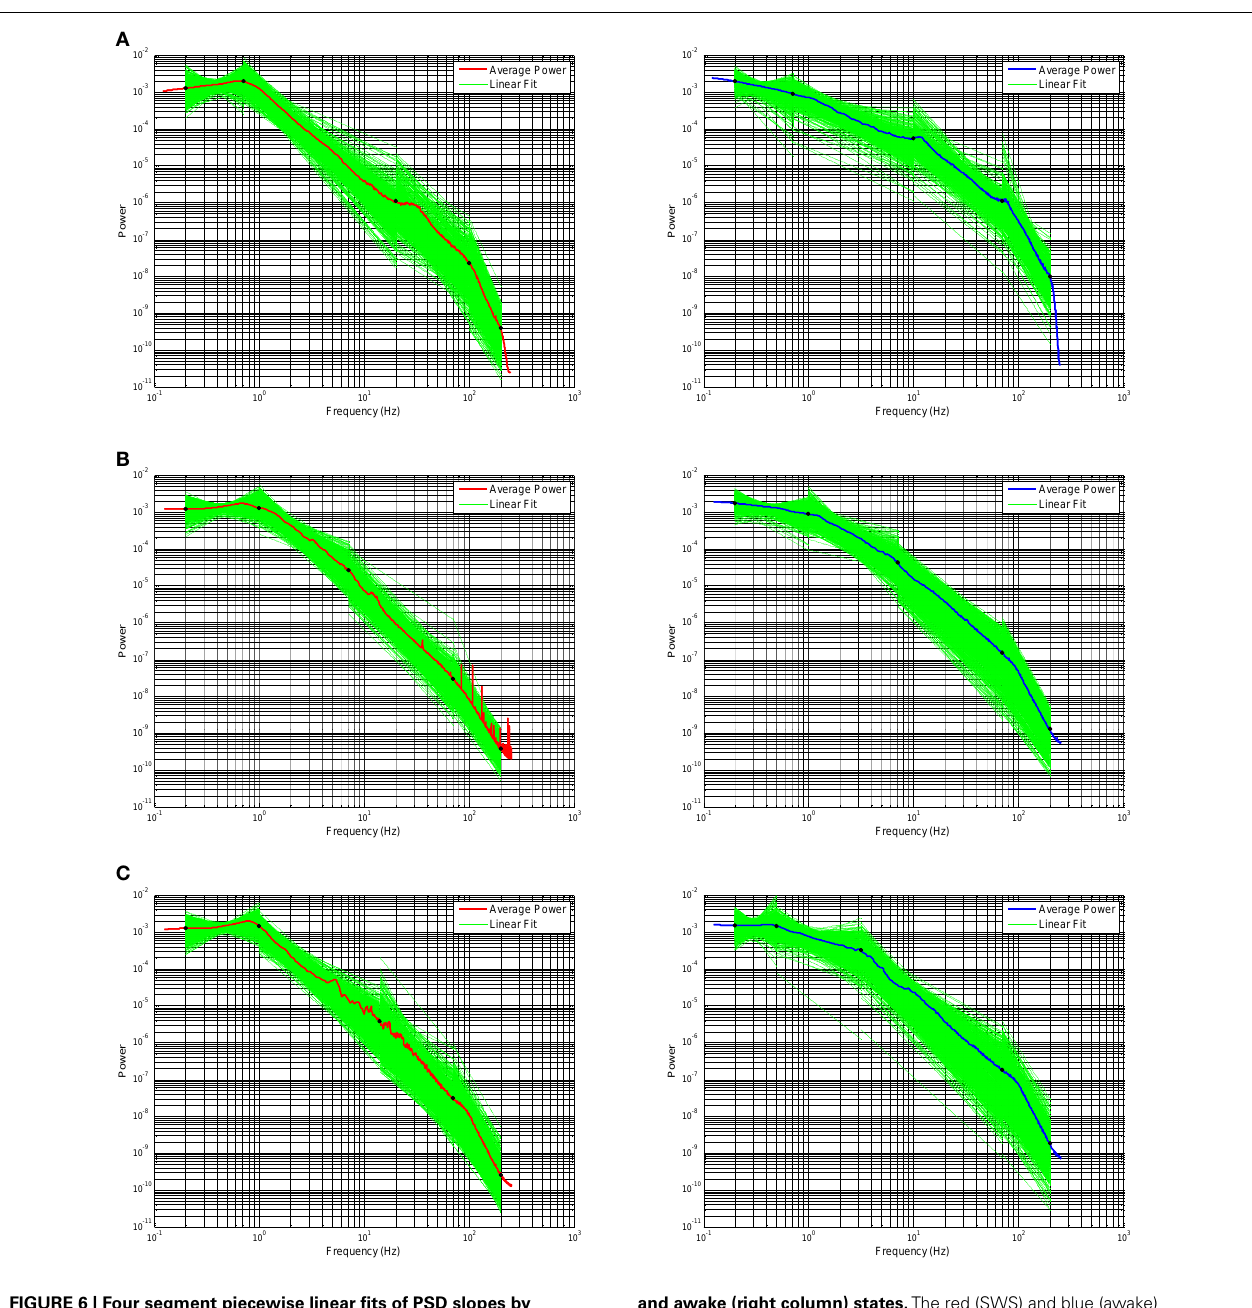
percent of electrode-interval data with a positive value in seg- ment one markedly decreases in the Awake data ( Figure 7E